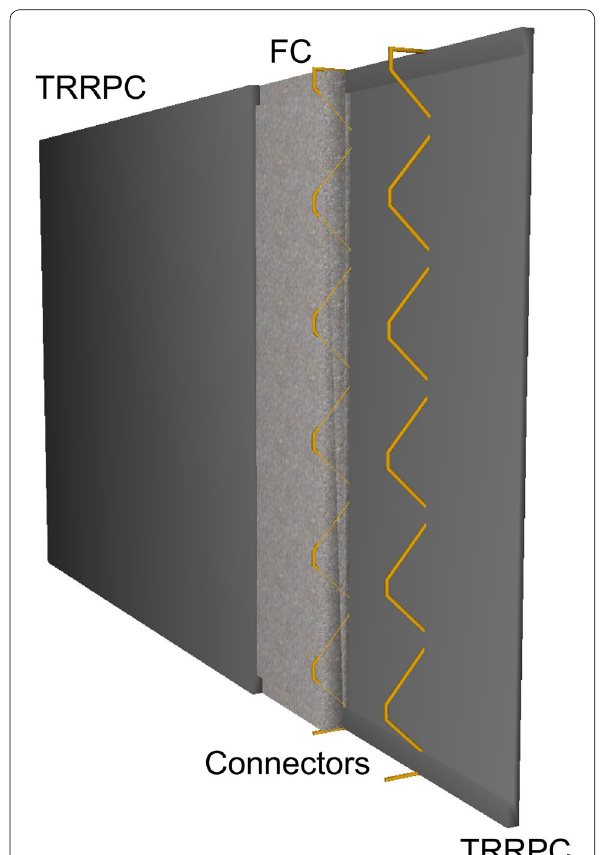
Fig. 1 Sandwich façade element